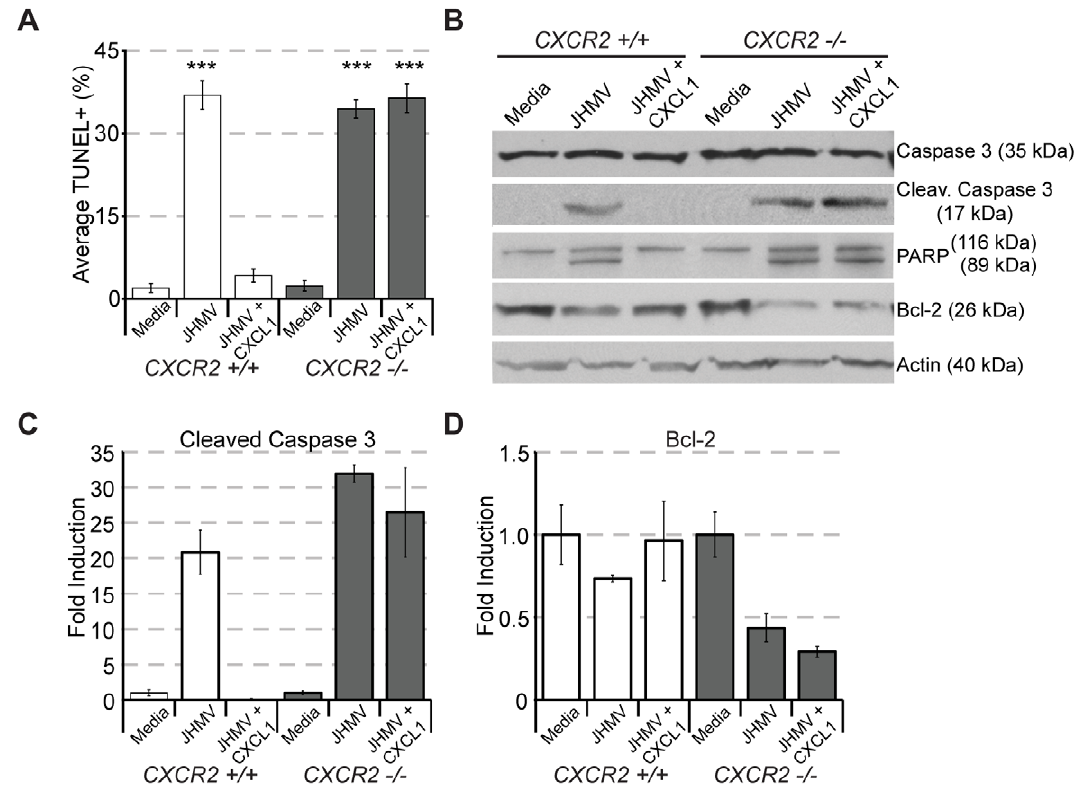
Figure 8. CXCR2 deficient oligodendrocytes are insensitive to CXCL1 – mediated protection from apoptotis. Differentiated CXCR2 + / + and CXCR2 2 / 2 oligodendrocyte enriched cultures were infected with JHMV (moi 1.0) and treated with recombinant mouse CXCL1 at 10 ng/ml. ( A ) While CXCL1 protected CXCR2 + / + oligodendrocytes from JHMV-mediated apoptosis, CXCR2 2 / 2 oligodendrocytes were not protected (*** p # 0.001, relative to Media). Protein lysates were collected from JHMV infected CXCR2 + / + and CXCR2 2 / 2 cultures and cleaved caspase 3, the caspase target PARP, and Bcl-2 expression were assessed ( B ). Densitometric quantification of the cleaved caspase 3 and Bcl-2 blots is presented panels C and D . Data in panels A–D is representative of three independent experiments.